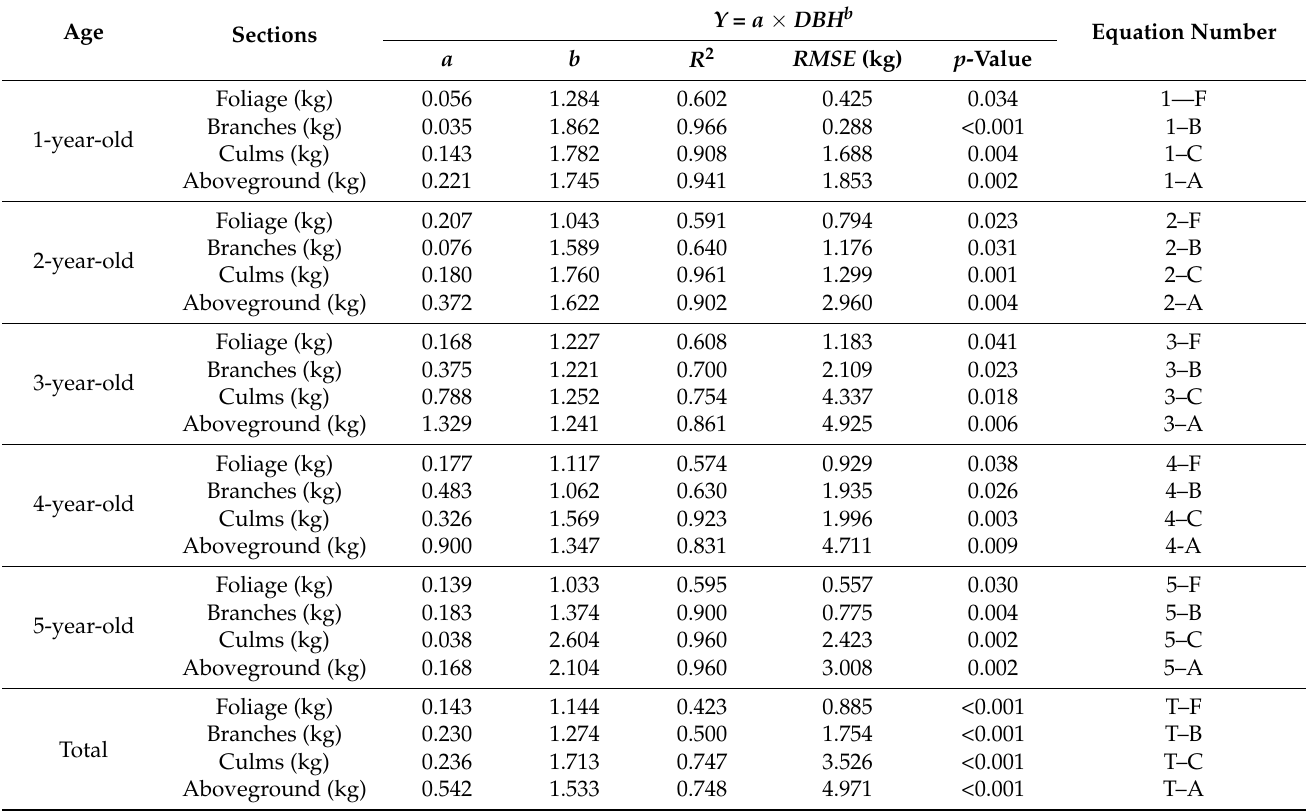
Table 3. The a and b parameters, R 2 and root mean squared error ( RMSE ) of each allometric model for predicting the biomass of various sections of Ma